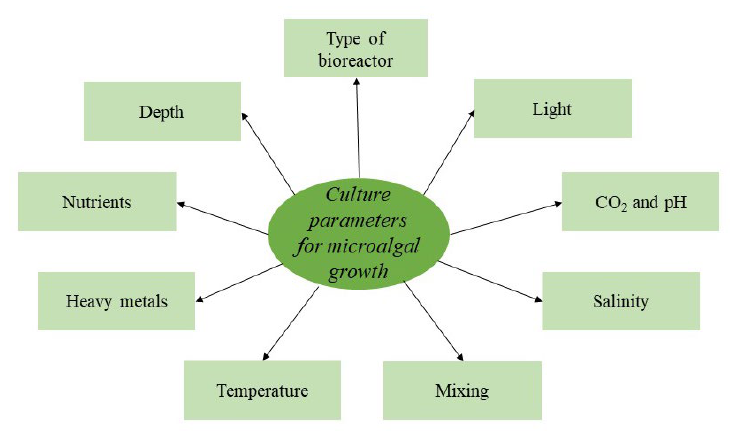
Fig. 2. Main parameters to optimize microalgal growth and biomass